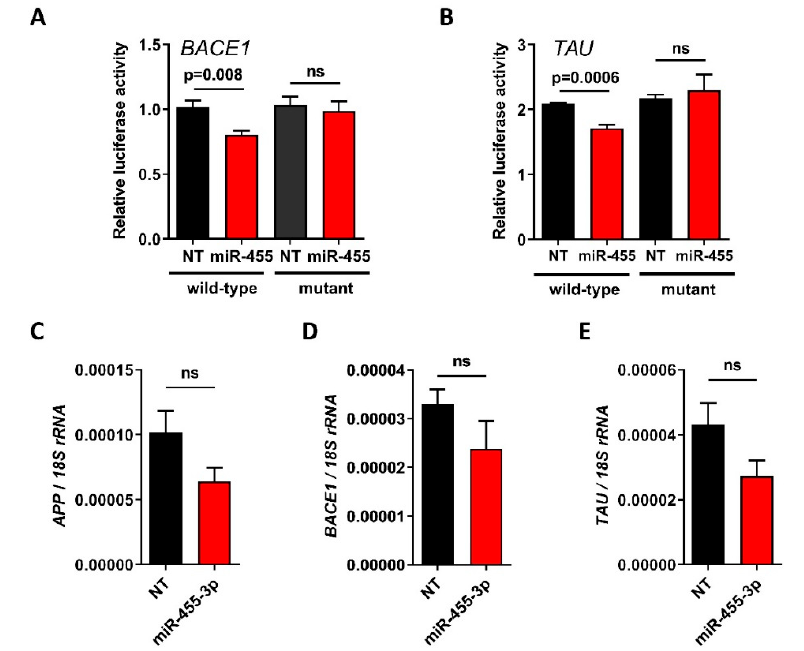
Figure 3. miR-455-3p directly targets BACE1 and TAU . Cells (DF1 fibroblasts) were transfected with the 3 ′ -untranslated region of BACE1 ( A ), TAU ( B ) or the corresponding seed site mutants, cloned into pmiR-GLO ± non-targeting control (NT) or miR-455-3p mimic (miR-455) and incubated for 24 h. Relative light units were normalized to Renilla activity. Bars show the mean ± SEM; n = 4. SH SY5Y neuroblastoma cells were transfected with miR-455-3p mimic or non-targeting control (NT) for 48 h prior to measurement of APP ( C ), BACE1 ( D ) and TAU ( E ) by qRT-PCR. Bars show the mean ± SEM, n = 3.